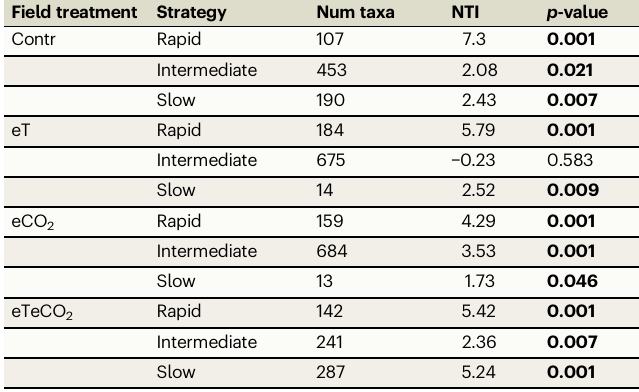
Table 2 | The nearest taxon index (NTI) of three growth strategies across climate change treatments Field treatment